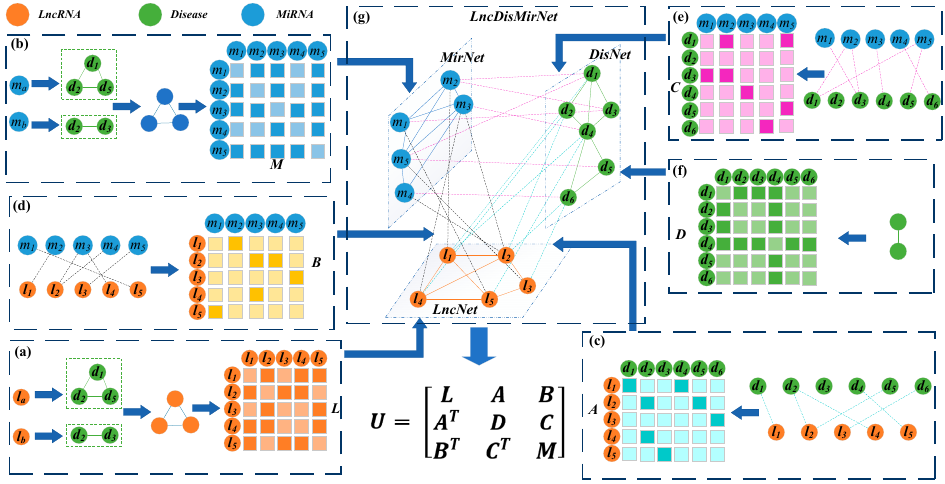
Figure 1. Construction and representation of a heterogeneous network with three different nodes. ( a ) LncRNA network (LncNet) and its adjacency matrix L were constructed by calculating the functional similarity of the lncRNAs according to their associated diseases. ( b ) Calculation of the functional similarity of the lncRNAs based on their related diseases and construction of miRNA network (MirNet) and the adjacency matrix M . ( c ) Establishment of the connexion between LncNet and disease network (DisNet) based on known lncRNA-disease associations and construction of the adjacency matrix A . ( d ) Connexion of LncNet and MirNet according to known interactions between lncRNAs and miRNAs and construction of the adjacency matrix B . ( e ) Connexion of the miRNAs and diseases according to known miRNA-disease associations and construction of the adjacency matrix C . ( f ) Computation of the similarities based on the DAGs of the diseases and construction of DisNet and the adjacency matrix D . ( g ) LncNet, DisNet, MirNet, and the connexions among them were used to construct the heterogeneous network LncDisMirNet and its adjacency matrix U